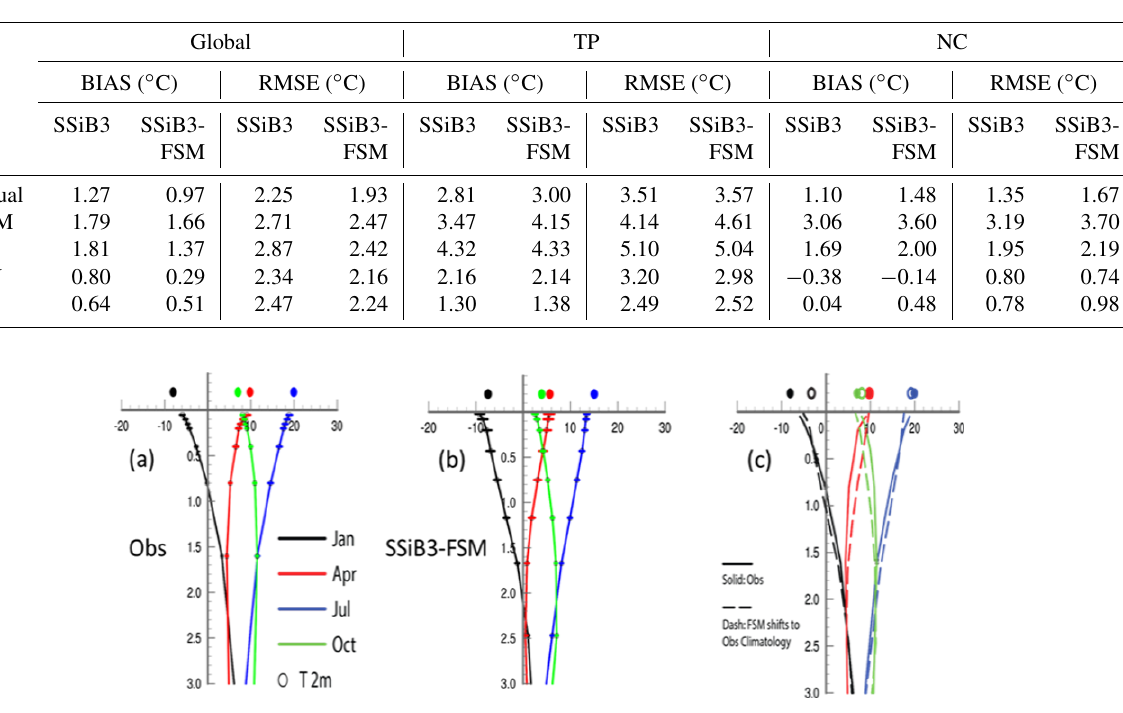
Figure 4. The seasonal soil temperature profile over the TP (14 sites) for 1981–2005. (a) Observation; (b) simulated by SSiB3-FSM; (c) comparison between the observation and the SSiB3-FSM shifts to the observation climatology.